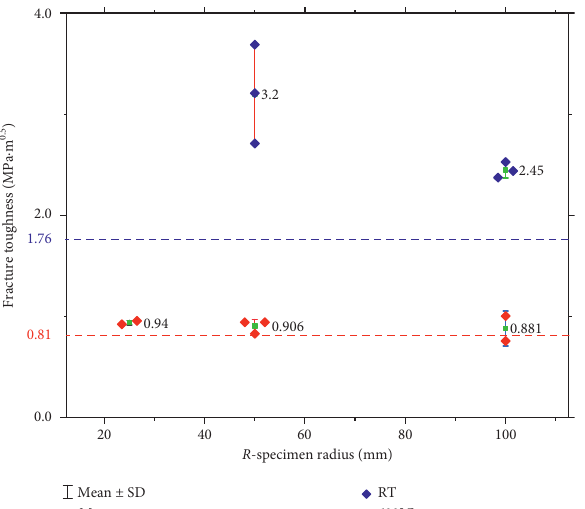
Figure 13: K IC estimated according to expression (11) (the dotted line represents the size effect parameter K IC , while the blue- and red- dotted lines represent the untreated granite and 600 ° C treated granite, respectively). Table 6: Comparison of K IC estimated according to expression (11) and K if. Effective structural dimension D (mm) K if (MPa · m 0.5